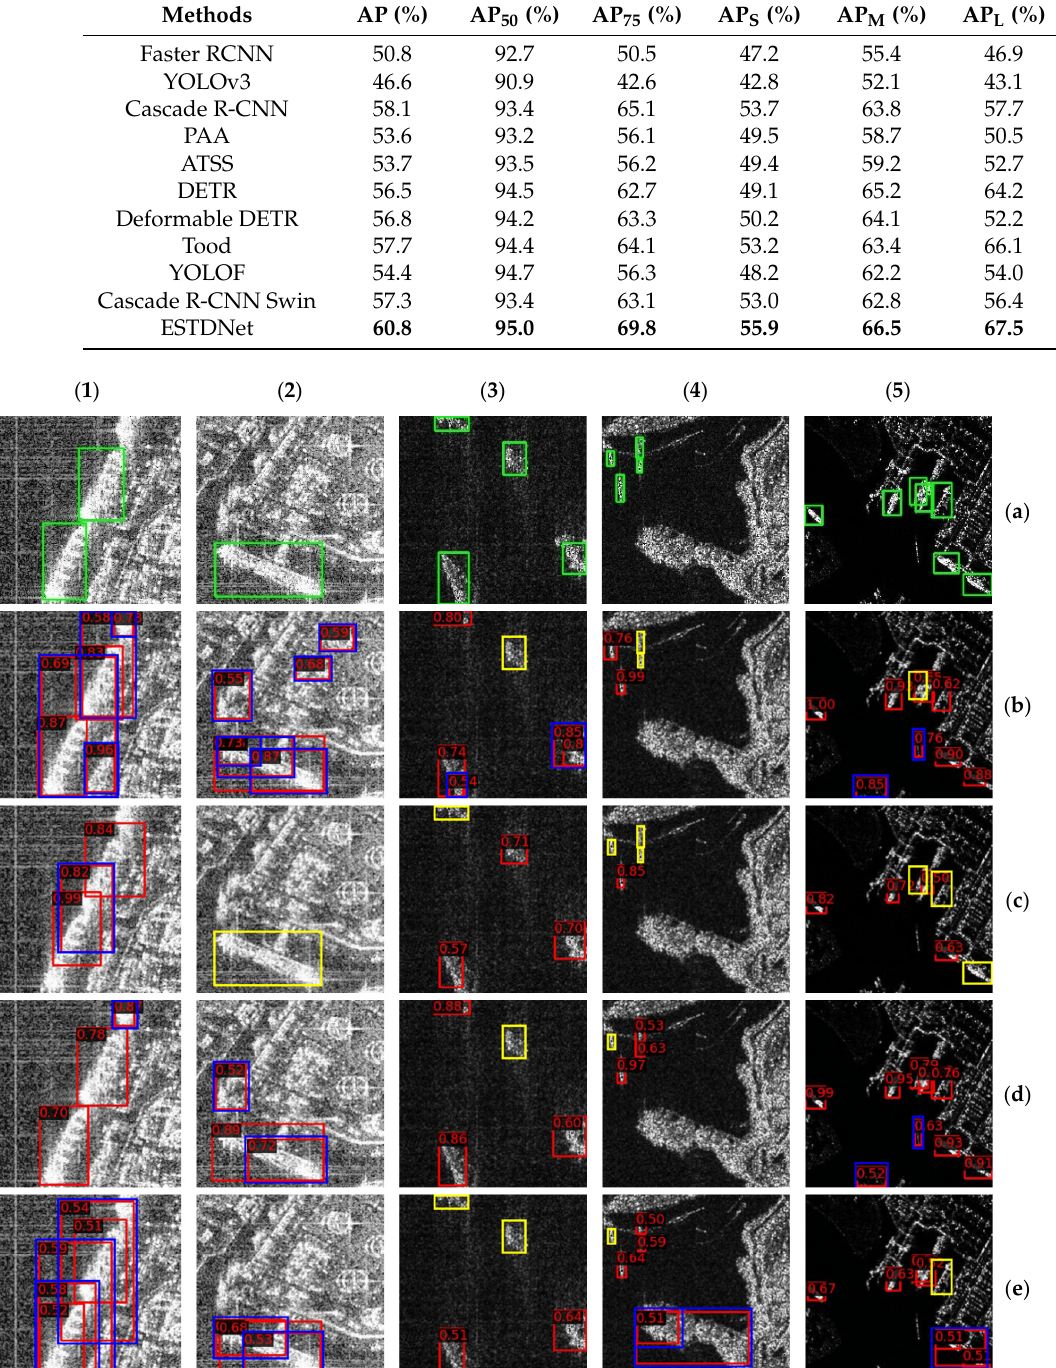
Table 5. The results of different methods on the SARShip dataset.